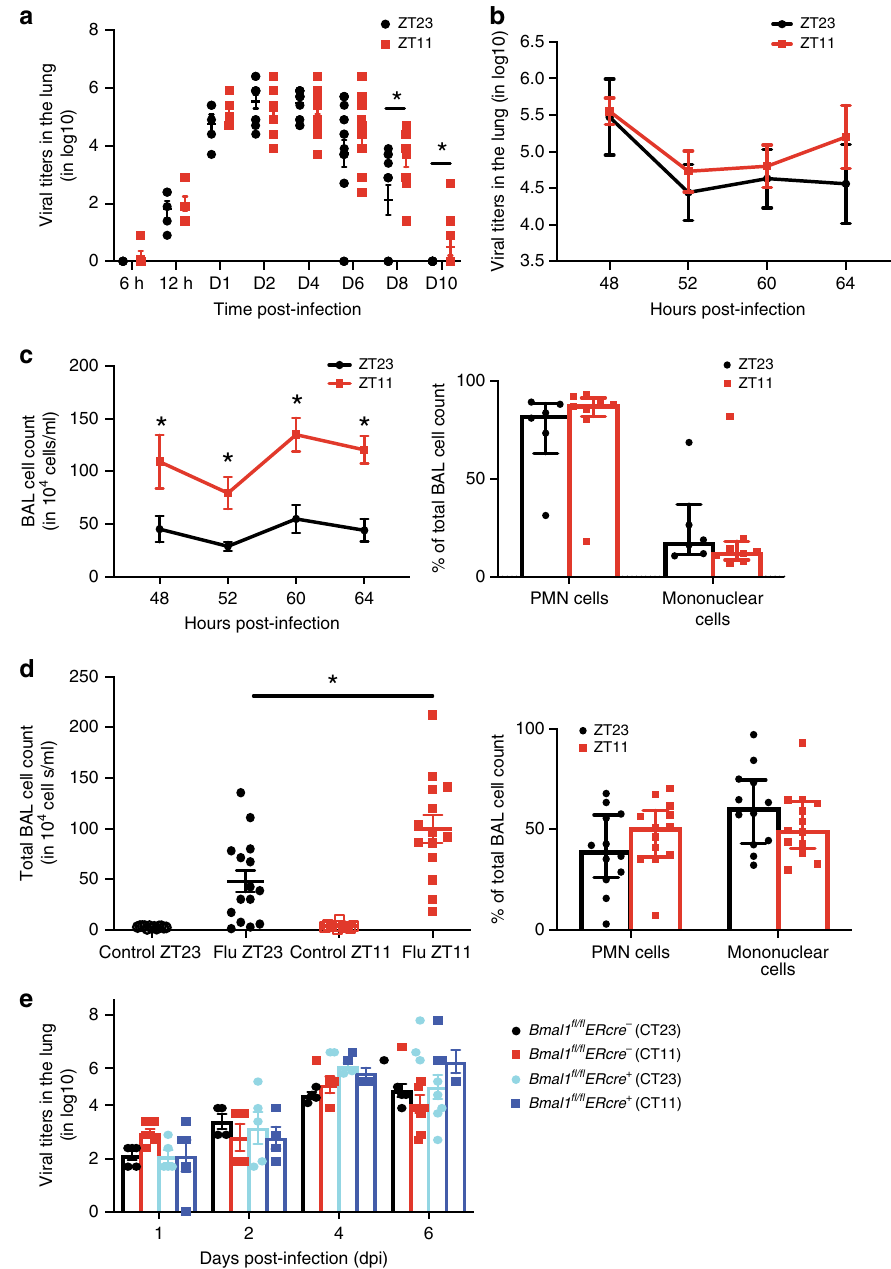
Fig. 2 The time of infection affect late-viral clearance, not early replication. Experimental design: after infecting mice at ZT23 or ZT11, viral titers were determined in the lungs harvested at serial time points, post infection. The time from infection to tissue collection was the identical for both groups. a Combined data for viral titers from 6 h to 10 day post infection ( n = 5 – 12 mice per group, student's t test; * p < 0.05, ZT23 vs. ZT11; The data were pooled across 3 – 4 independent experiments). b Viral titers from ZT23 and ZT11 groups were determined at 48, 52, 60, and 64 h. c Bronchoalveolar lavage (BAL) was also collected at the same time points as in panel b , quanti fi ed and the differential was determined by staining cytospin preparations. Data were compiled from 4 independent experiments for both panels b and c , including one from reverse LD cycles (total n = 6 – 8 per time point, two-way ANOVA; * p < 0.05 for time of infection, NS for time of dissection). d Right panel: the total BAL cell count on day 6 p.i. from mice who received either IAV or PBS at ZT23 or ZT11. The data compiled from three independent experiments (total n = 11 – 13 per time point, one-way ANOVA; * p < 0.05, ZT23 vs. ZT11). Left panel: differential of the BAL cells from both IAV-infected groups. e Viral titers from Bmal1 fl / fl ERcre + mice and their cre − littermates (treated as in Fig. 1e), and samples harvested on day 1, 2, 4, and 6 dpi. (total n = 4 – 9 per time point, two-way ANOVA; p < 0.05 for days after infection and N.S. time of infection i.e., CT11 vs. CT23. The data were pooled across four independent experiments). The data expressed as mean ± SEM. Source data are provided as a Source Data fi